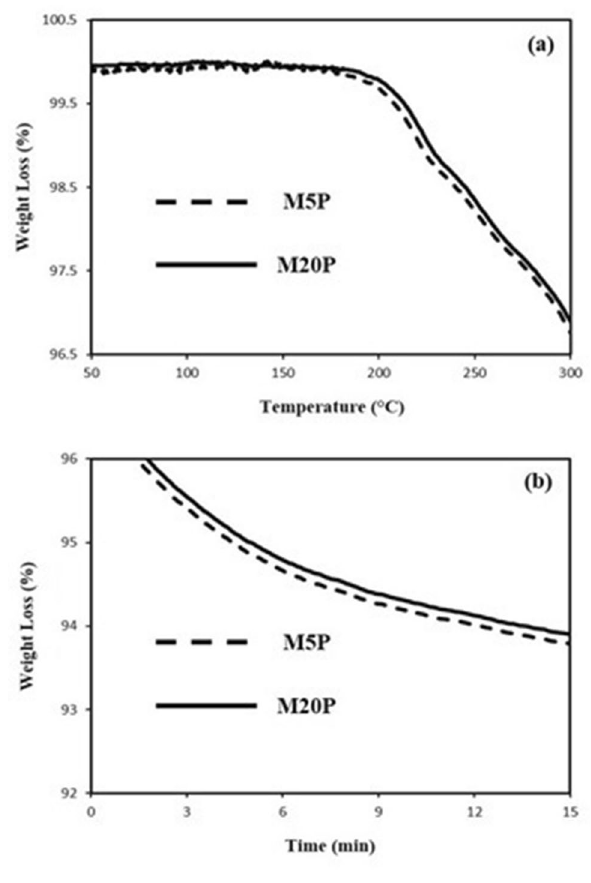
Fig. 7 The TGA analysis results of M5PA and M20PA samples a at ◦ C 300 and b after 15-min holding at 300